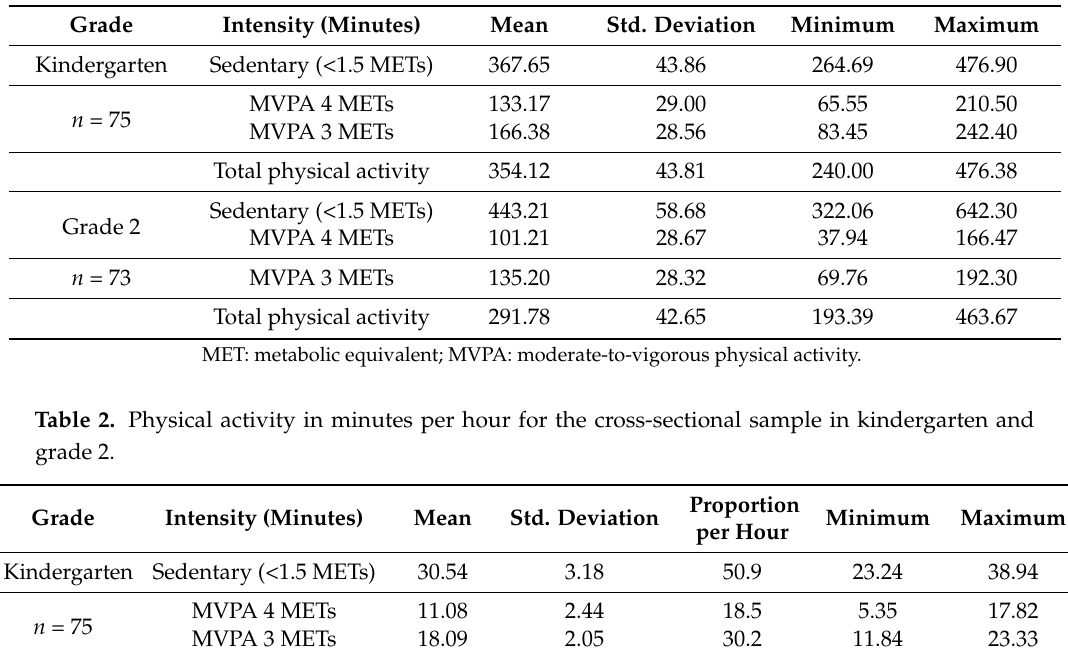
Table 1. Physical activity in minutes per day for the cross-sectional sample in kindergarten and grade 2.